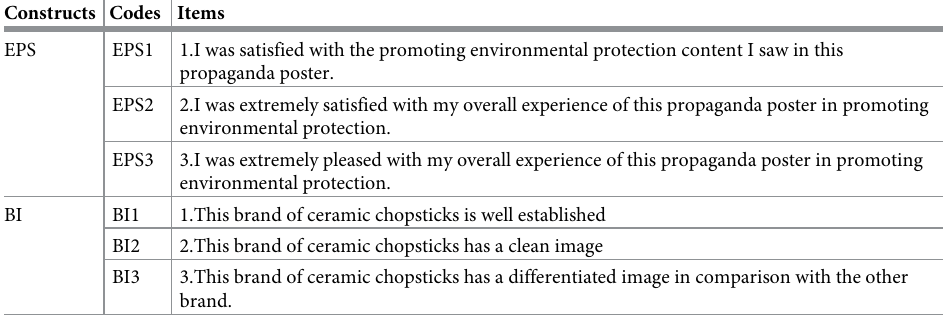
Table 2. Composition of focus group